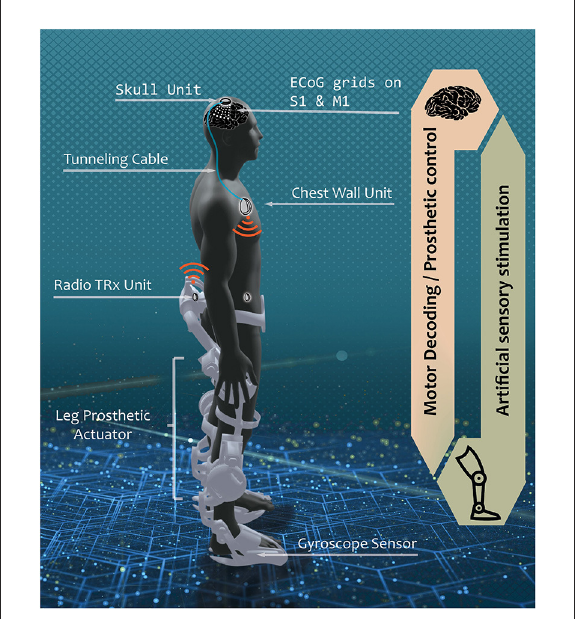
FIGURE1 Envisioned fully implantable BD-BCI system. In a hypothetical scenario where the BD-BCI system is implanted in persons with severe spinal cord injury, a downstream motor signal from ECoG electrodes on the primary motor cortex (M1) is amplified, multiplexed, and digitized by the skull unit (SU) to bypass the damaged spinal cord connection through tunneling cable to reach the chest wall unit (CWU). The signal is decoded in the CWU which wirelessly actuates leg prosthetic for walking. Upstream sensation of walking is encoded with gyroscope sensor. The sensory information is wirelessly transmitted to the CWU. The CWU converts the received kinematic info into electrical pulse train which travels via the tunneling cable, multiplexed in the SU to stimulate the desired loci in the primary sensory cortex (S1) to elicit artificial sensation. The current study focuses on the development of upstream electrical stimulator, encompassing the CWU analog to the SU